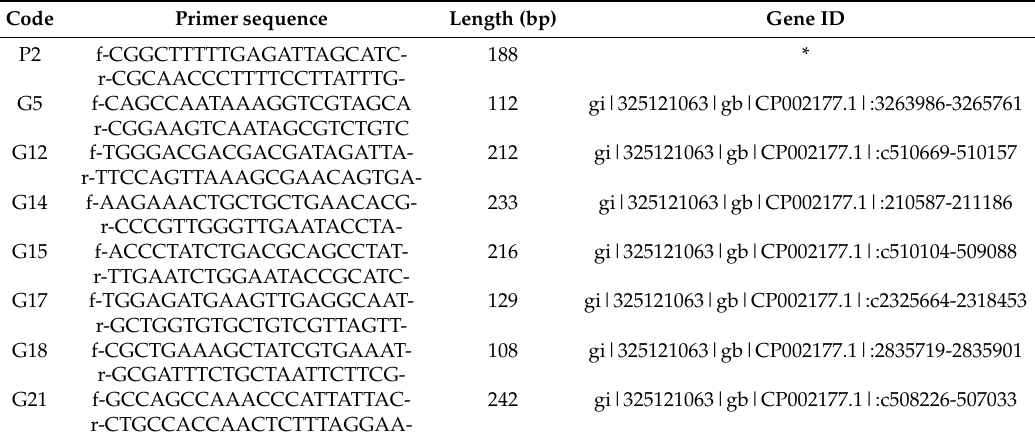
Table 1. Primer sequences for